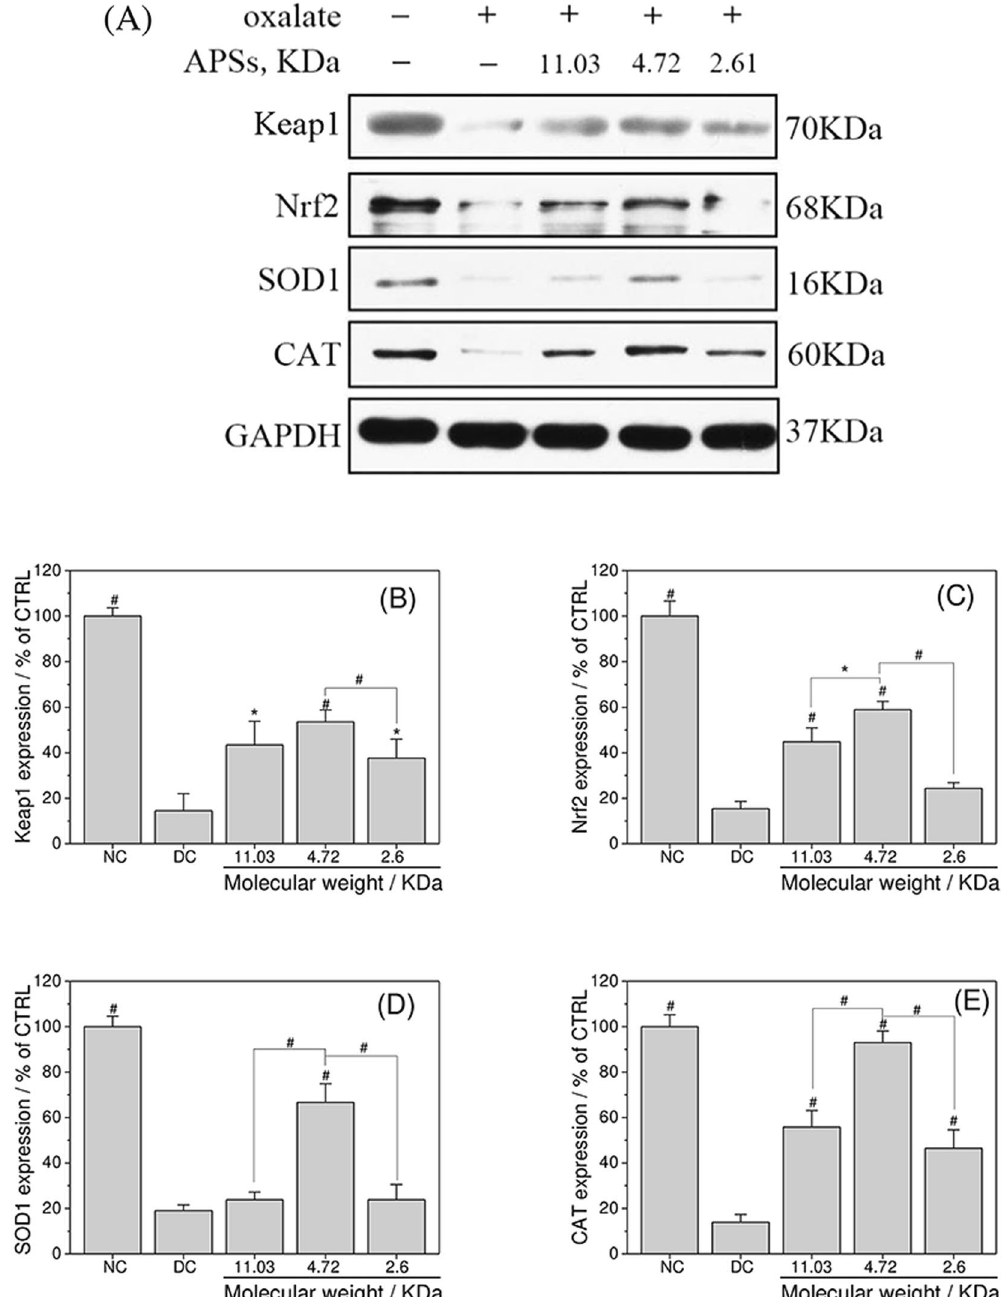
Figure 10. APSs with different Mws influenced the Nrf2–Keap1 signaling pathway. Protein expression of Keap1, Nrf2, SOD1 and CAT were detected by Western blot analysis ( A ). Protein expression of Keap1 ( B ), Nrf2 ( C ), SOD1 ( D ) and CAT ( E ) were quantified by Imagel software. Compared with DC group, * P < 0.05; # P <